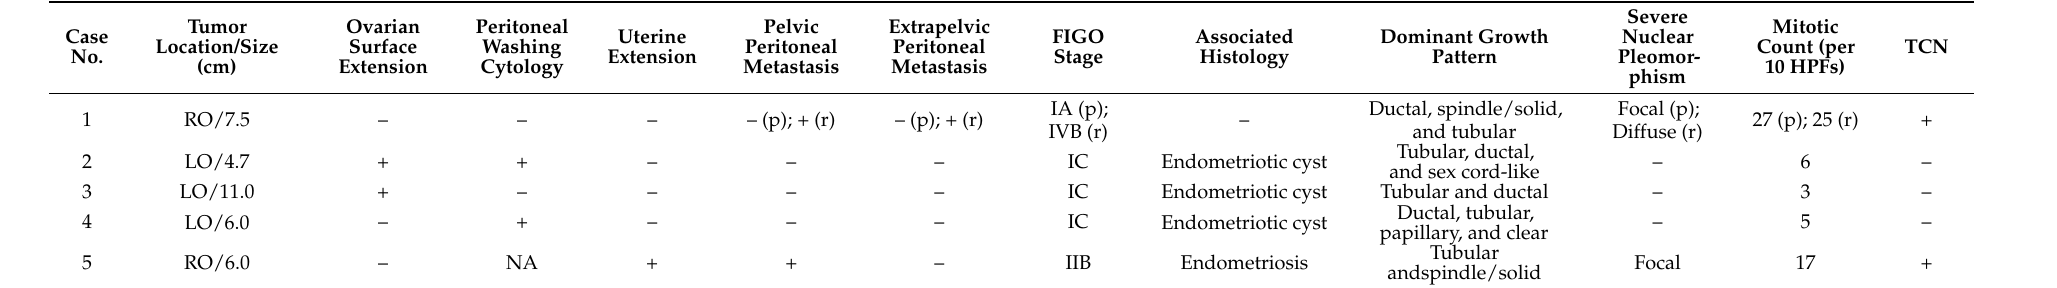
Table 3. Pathological